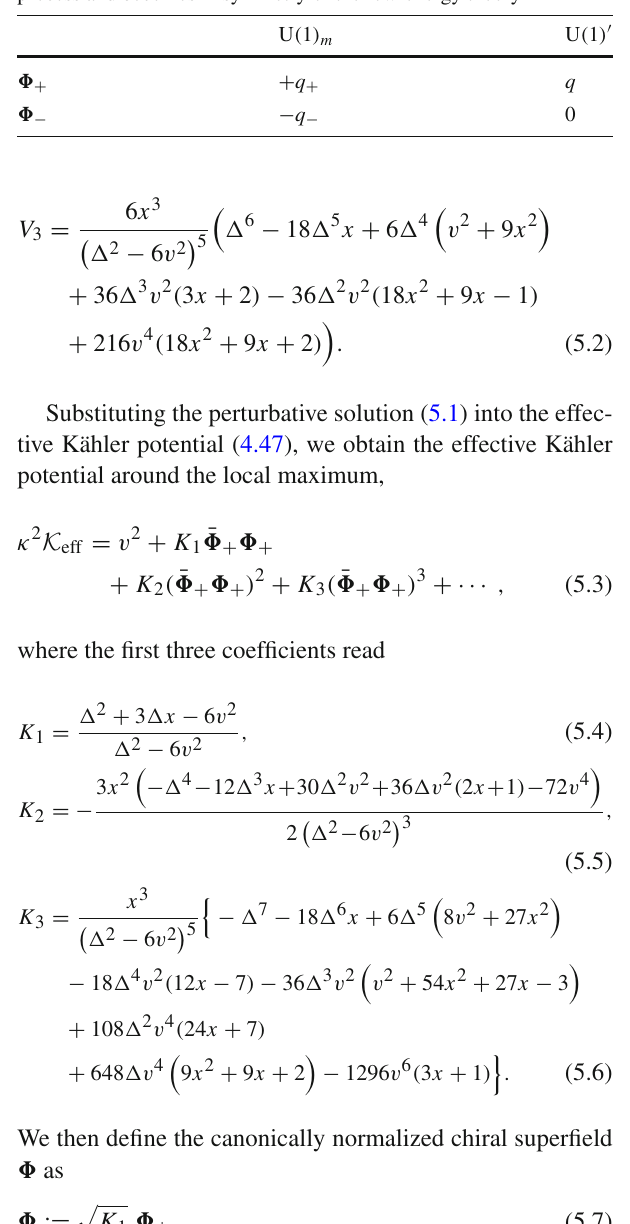
Table 1 The chiral multiplet (cid:2) + and (cid:2) − are charged under U ( 1 ) m × U ( 1 ) (cid:3) . Note that U ( 1 ) (cid:3) does not play any role during the integrating out process and becomes R-symmetry of the low-energy